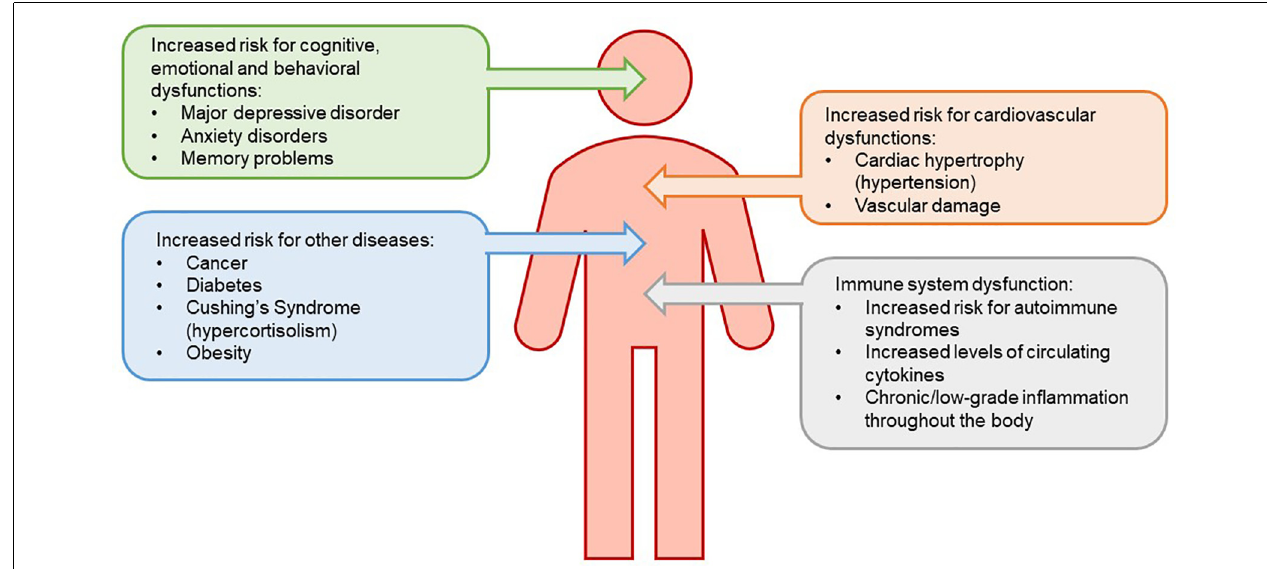
FIGURE 1 | Chronic stress leads to reduced sensitivity of the negative feedback system that governs the hypothalamic-pituitary-adrenal (HPA) axis. The loss of this negative feedback system is due to an increased level of circulating glucocorticoids (GCs). HPA axis dysregulation results in downstream physiological consequences, increasing risk for immune system dysfunction, mood disorders, metabolic disease, and cardiovascular